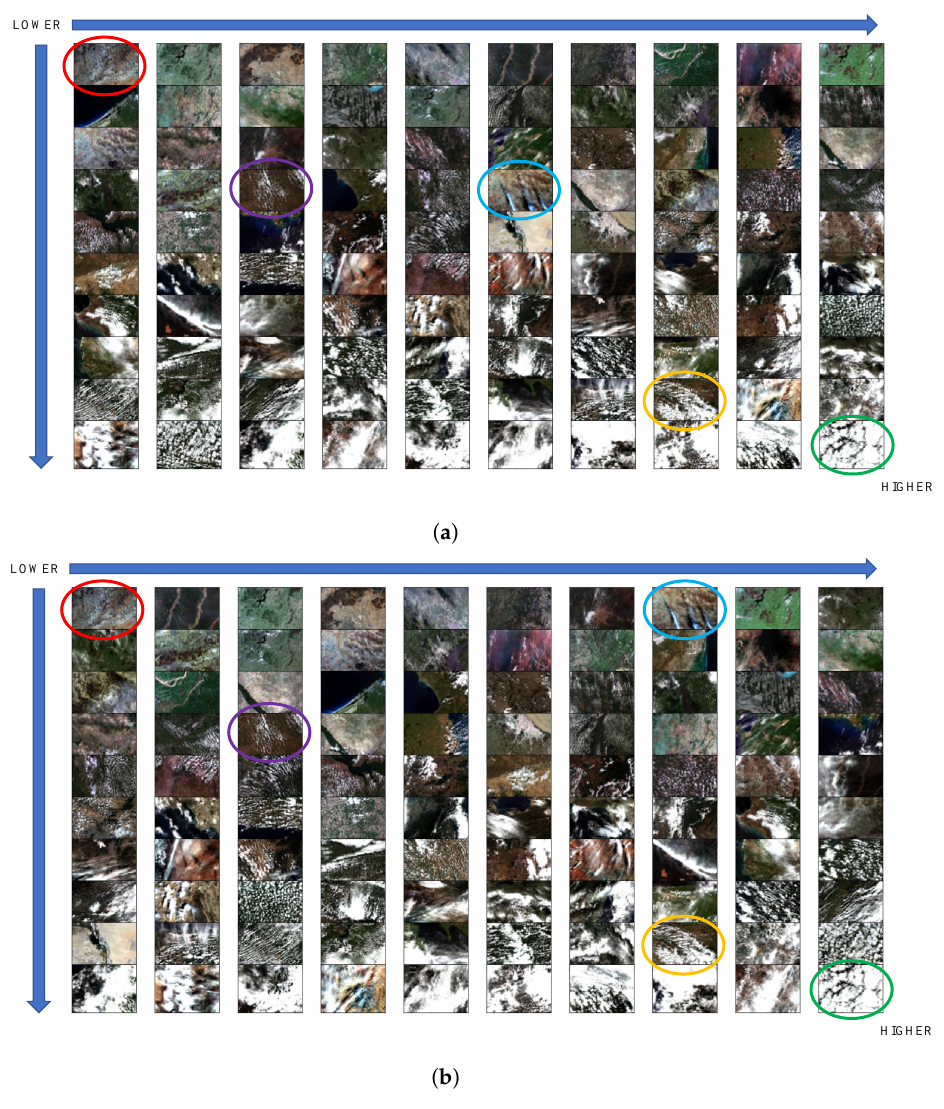
Figure 5. Rank of test images according to cloud coverage obtained from CNN. Colored circles are used to tag images. ( a ) Results based on NU-Net; ( b ) Results based on NU-Net-mod.